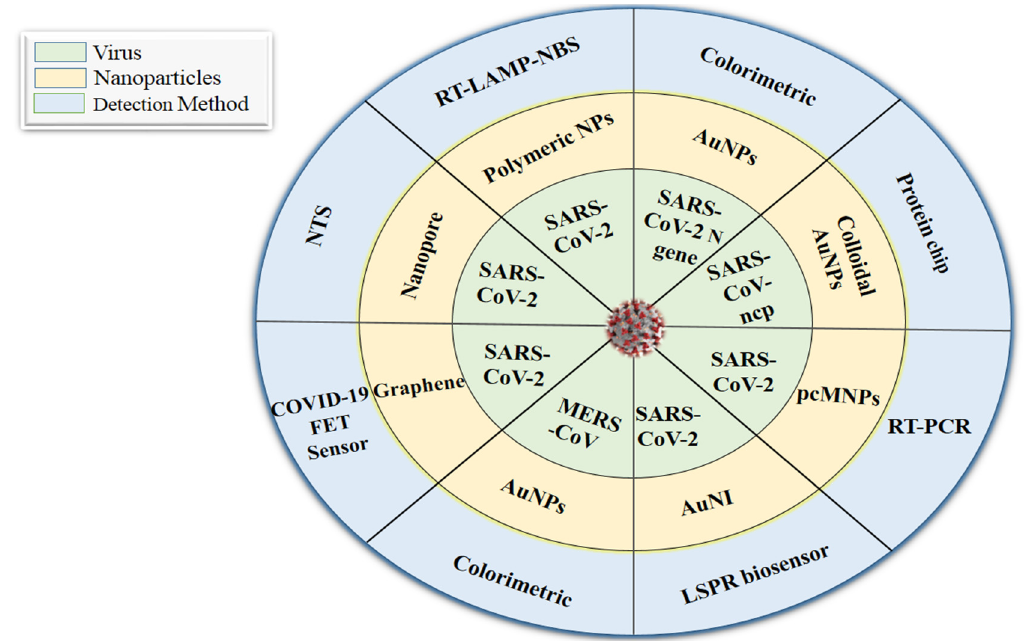
Figure 3. Nanotechnology-based approaches for MERS-CoV, SARS-CoV, and SARS-CoV-2 detection. Nanoparticles (NPs); gold NPs (AuNPs); field-effect transistor sensor (FET sensor); Middle East respiratory syndrome-coronavirus (MERS-CoV); severe acute respiratory syndrome coronavirus 2 (SARS-CoV-2); SARS-CoV-nucleocapsid protein (SARS-CoV-ncp); RT-LAMP associated with NP-based biosensor assay (RT-LAMP-NBS); Poly amino ester with carboxyl groups-coated magnetic NPs (pcMNPs); gold nanoislands (AuNIs); nanopore-targeted sequencing (NTS); localized surface plasmon resonance (LSPR); reverse transcription-polymerase chain reaction (RT-PCR).